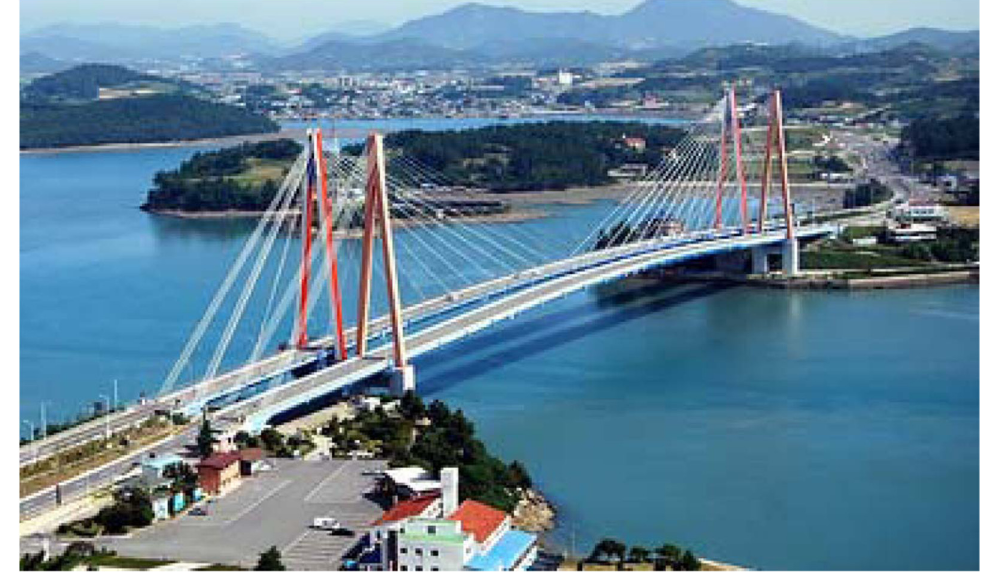
Figure 10. Jindo Bridge.